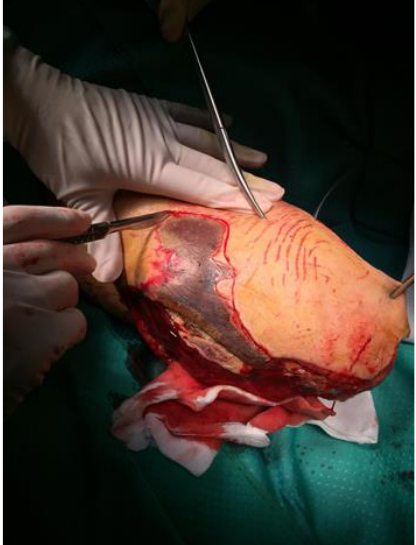
Figure 2. Surgical treatment with limb amputation. On 22 August, microbiological evaluation of urine sample documented an infection sustained by the Acinetobacter Bahmani complex (Table 4); therefore, tigecycline (30 mg/12 h) was added to the therapy, but after 7 days, due to both the progression of leukemia and the presence of a severe antimicrobial resistance infection (Table 4), the child died. Table 4. Acinetobacter Bahmani complex infection in urine sample on 22 August 2019. S: sensitive; R: resistant.